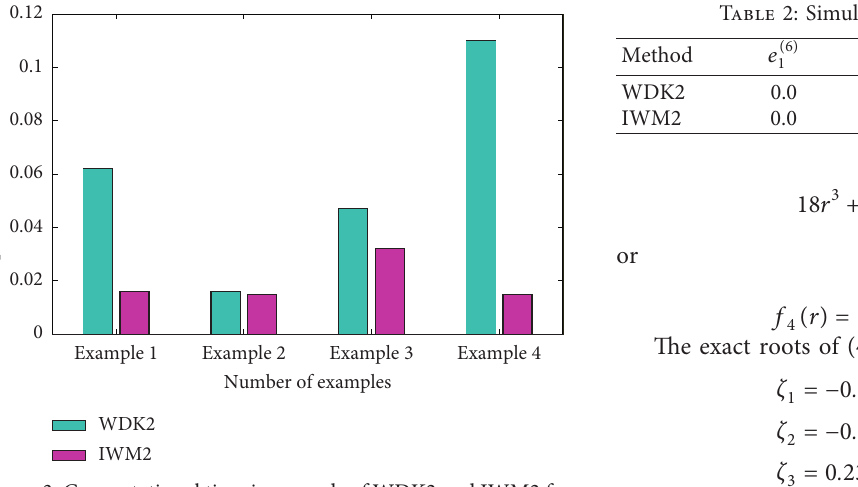
Figure 3: Computational time in seconds of WDK2 and IWM2 for nonlinear function f